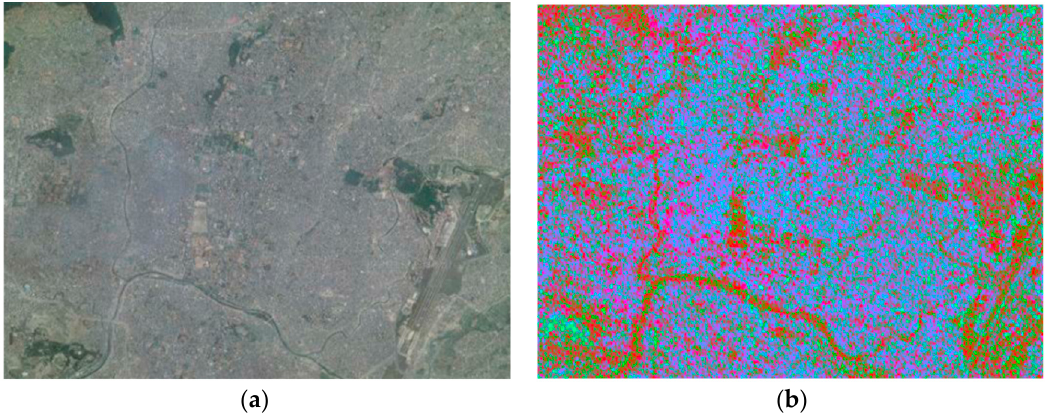
Figure 4. Earthquake Damage Visualization (EDV) imagery showing forward (red), backward (green), and change-free (blue) components: ( a ) Google map imagery of the Kathmandu Valley dated 3 May 2015; ( b ) the corresponding EDV imagery.